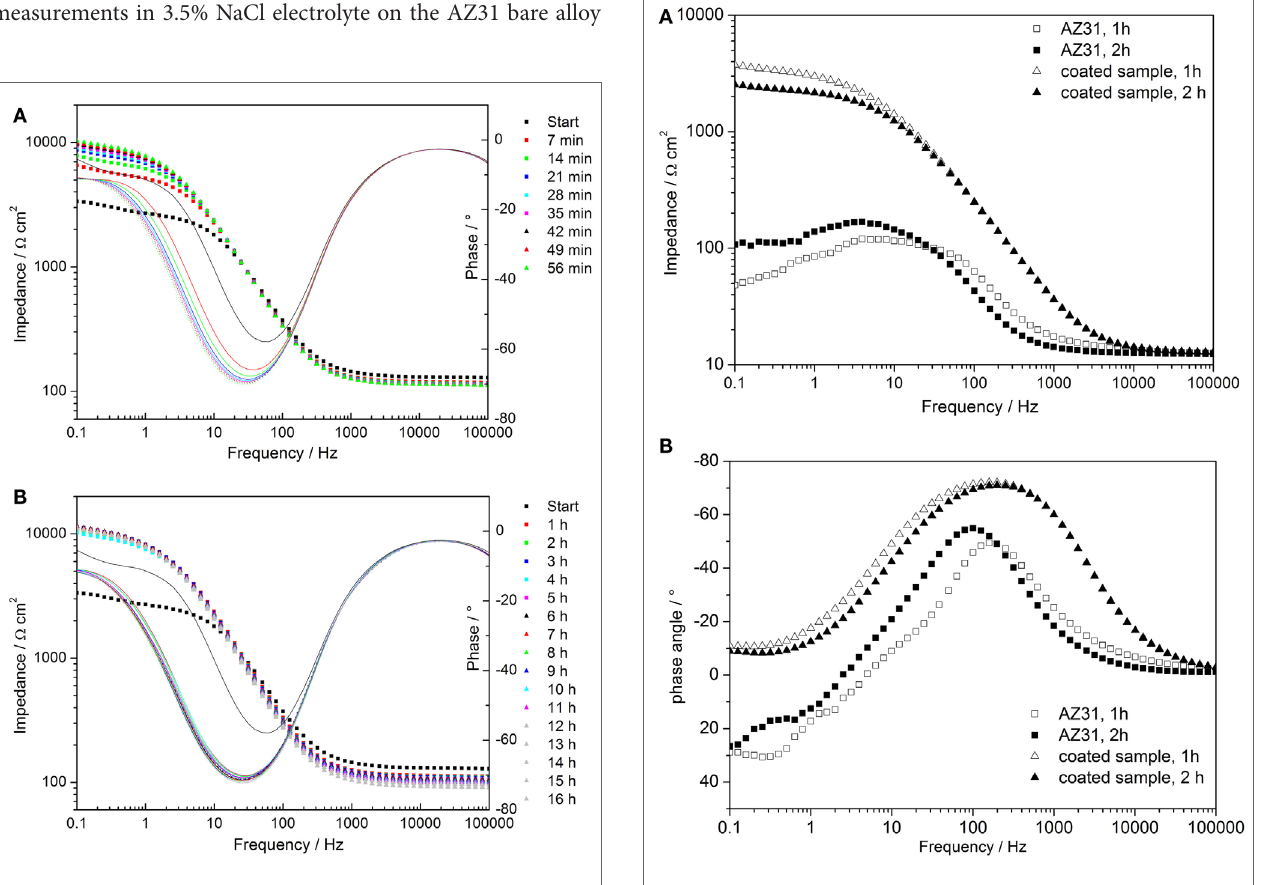
FigUre 7 | (a,B) Time-dependent plots of impedance measurements of cerium oxide film immersed in 1 mM NaOH with 0.05M NaCl; (a) Bode plot of evolution during first hour; (B) Bode plot of hourly development.